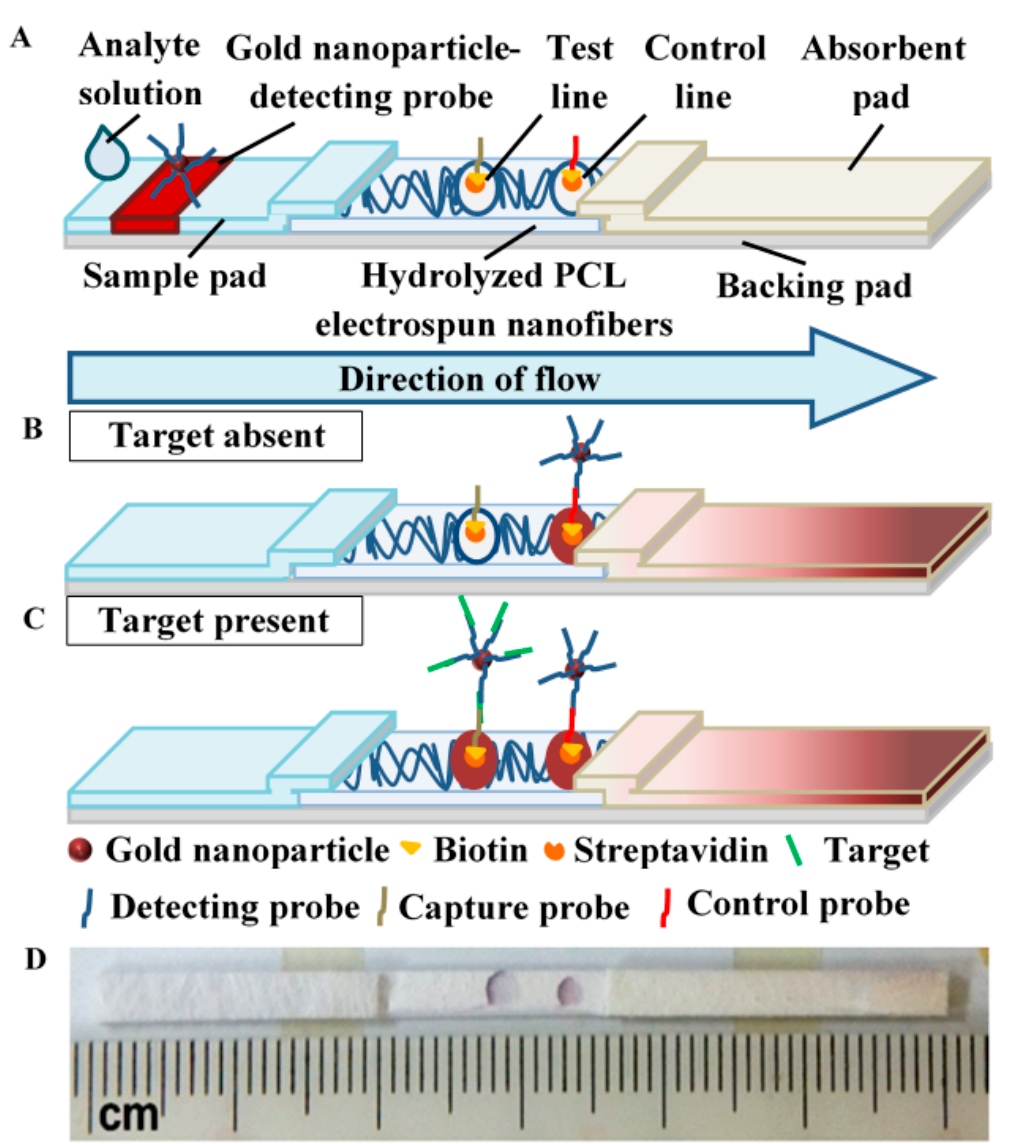
Figure 2. Schematic of lateral flow assay (LFA) with hydrolyzed electrospun PCL nanofibers for DNA detection. The common LFA strip was assembled with the hydrolyzed electrospun PCL nanofibers ( A ); The analyte solution would flow from the sample pad to the backing pad through the hydrolyzed membrane. In the absence of target analyte, the assay would not show a signal on the test line ( B ); In the presence of target analyte, the target would bind to the detecting probe and capture probe and produce a positive signal on the test line ( C ); A representative image of the test strip made of electrospun PCL nanofibers ( D ).